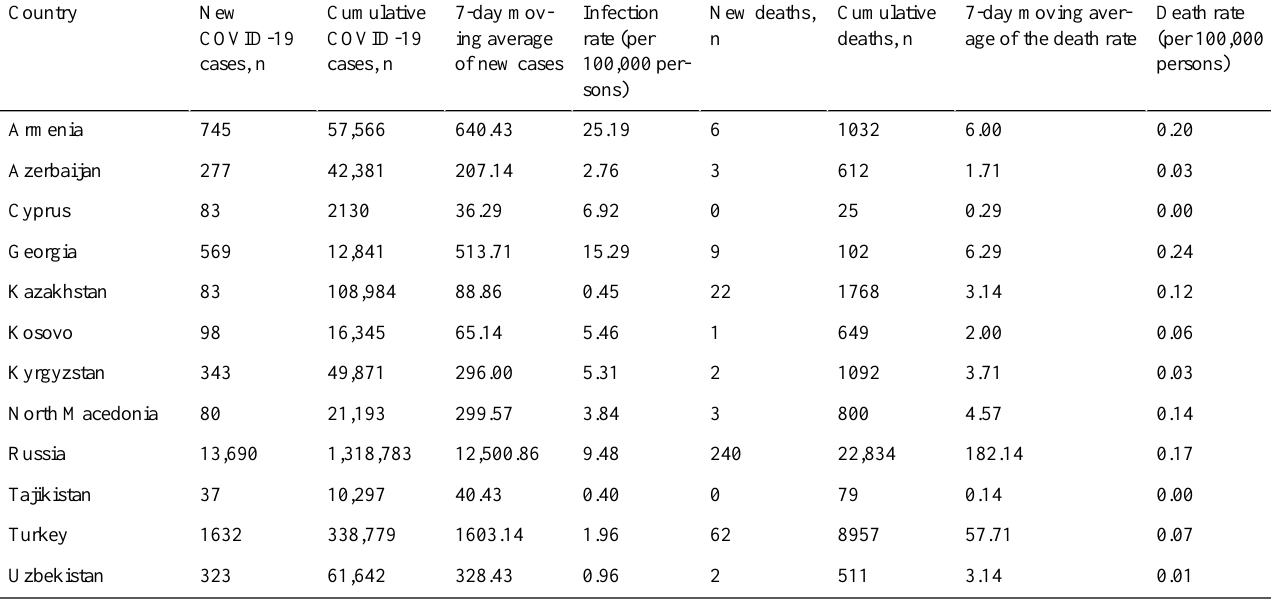
Table 3. Static surveillance metrics for the week of October 7-13, 2020.